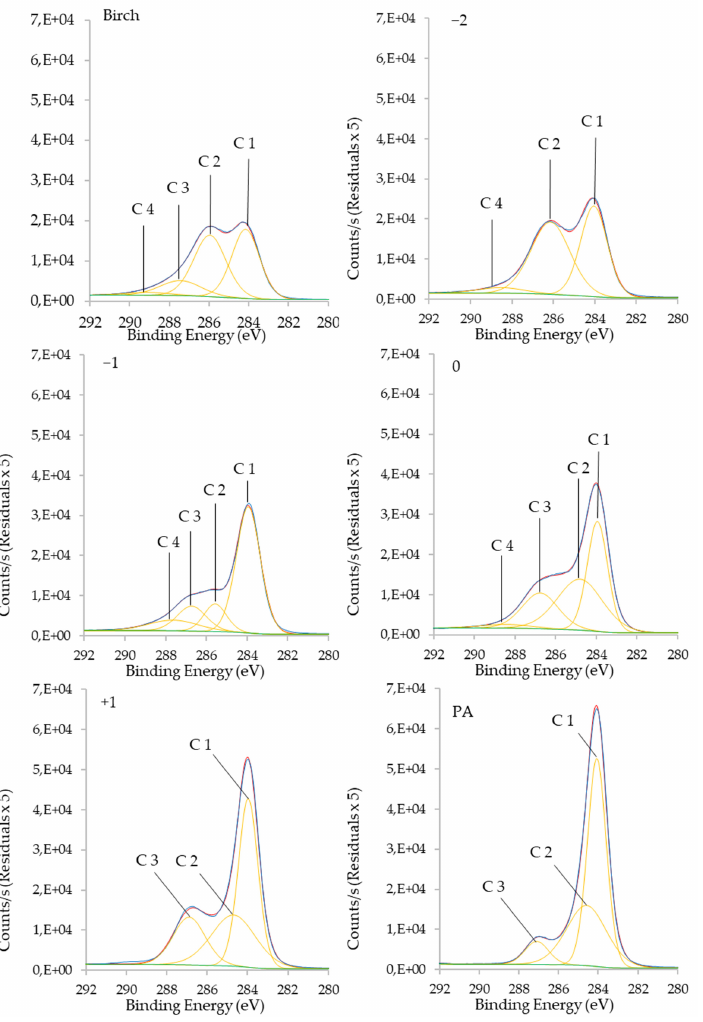
Figure A1. Representative deconvoluted XPS spectrum with relative areas of the C 1, C 2, C 3 and C 4 binding energy regions of the birch solid wood specimens, overmolded with PA 6, within the cross section of a